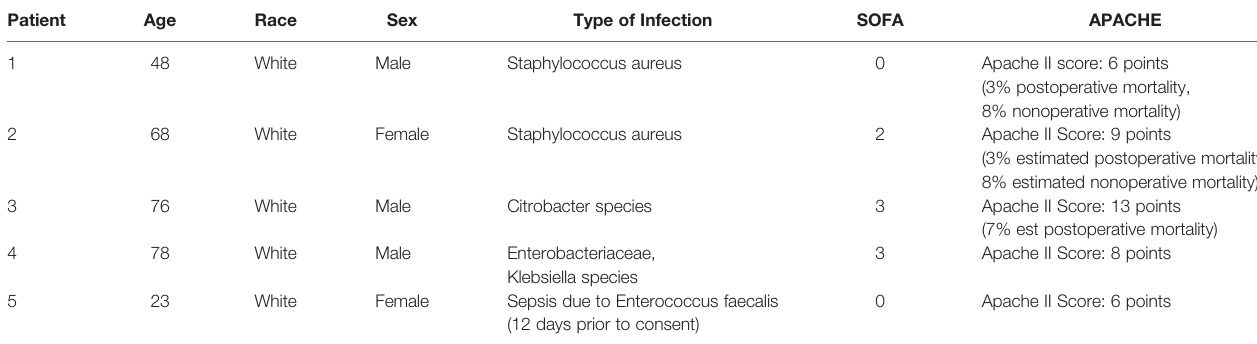
TABLE 2 | Description of sepsis